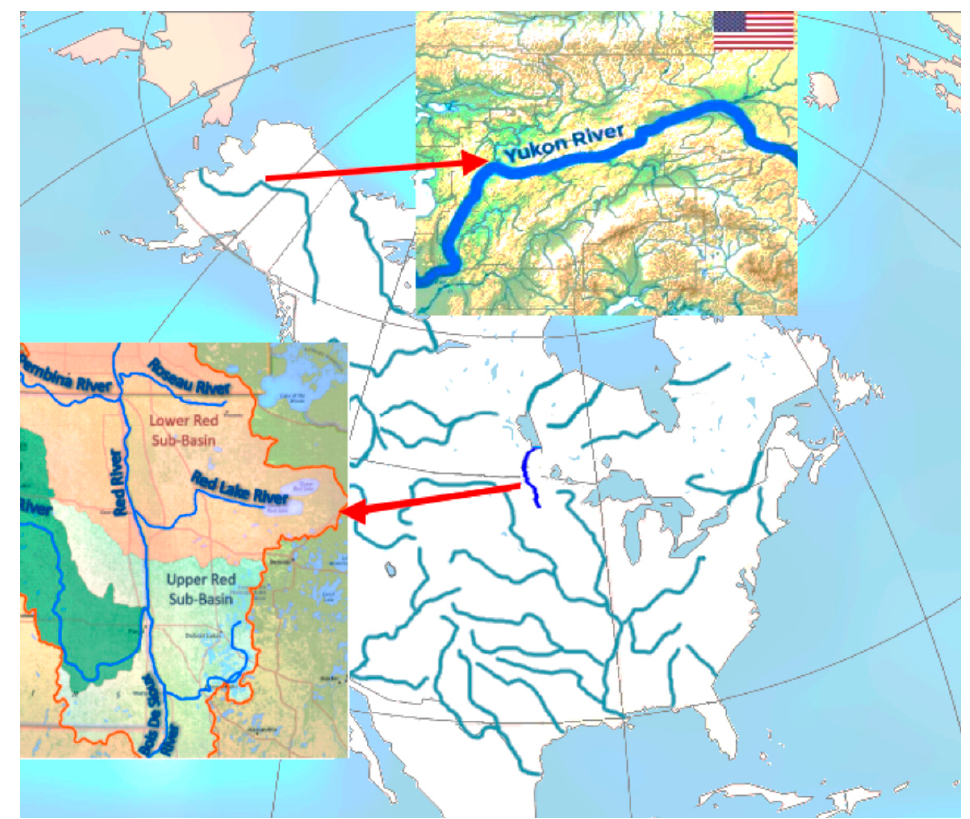
Figure 1 . The location map of the study sites in the United States. The thick blue lines mark the major rivers in North America.